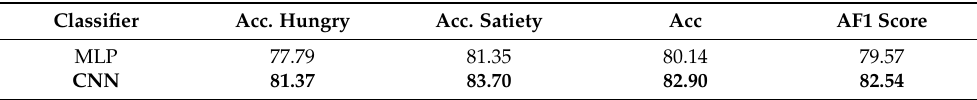
Table 8. Results of the classification of hunger and satiety using feature learning approaches. Classifier Acc.